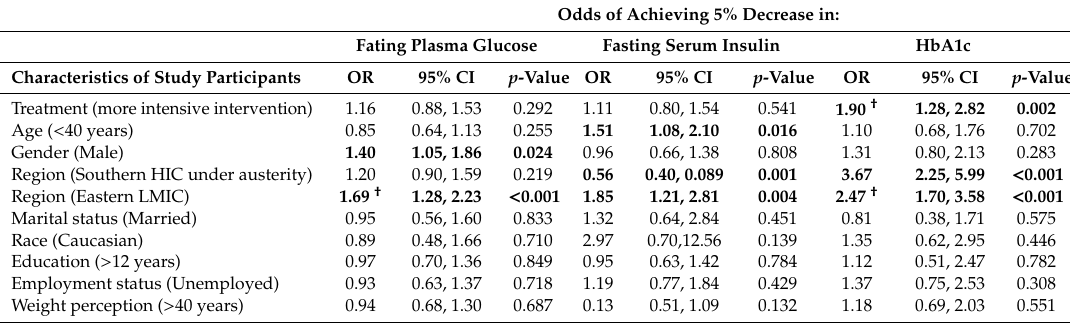
Table 4. Odds of achieving a 5% decrease in glycaemic profile values during the 2 years of the Feel4Diabetes program by participants’ characteristics. Odds of Achieving 5% Decrease